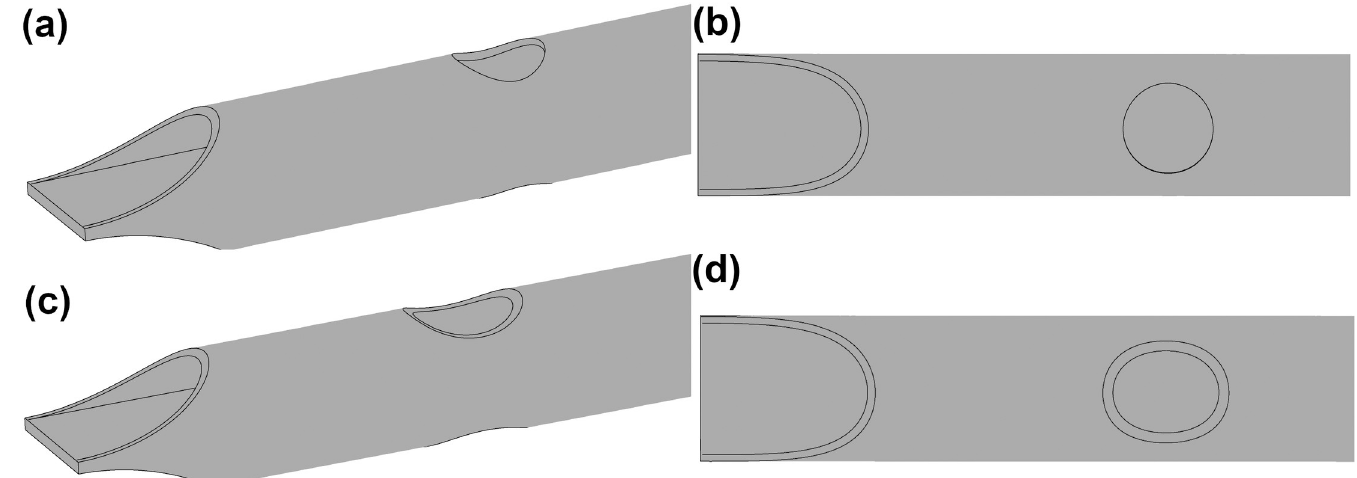
Fig 2. Medium size side-holes for the circular (a)-(b) and oval (c)-(d) shaped